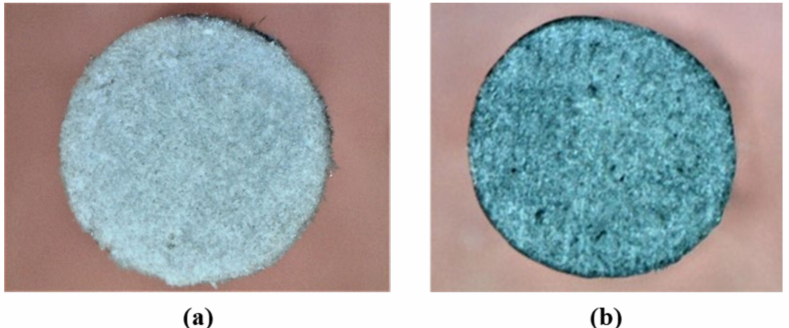
Figure 6. Microscopic images at 20 × magnification showing cross-section of ( a ) neat pultruded GFRP bar and ( b ) pultruded GFRP bar incorporating 0.5 wt.% COOH-MWCNTs.